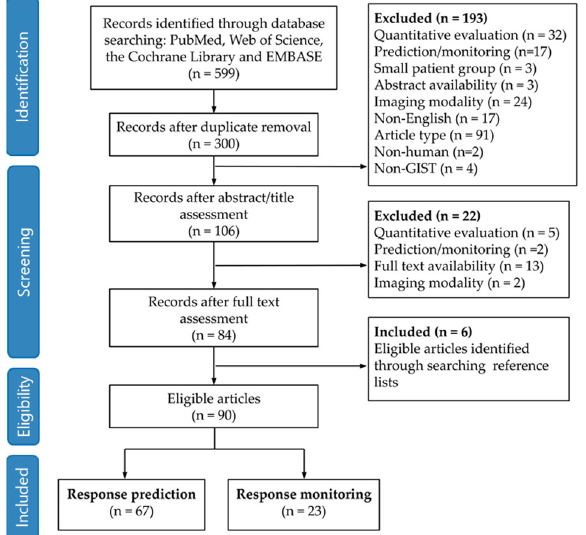
Figure 1. Preferred Reporting Items for Systematic Reviews and Meta-analysis (PRISMA) flowchart showing all the exclusion criteria. A total of 90 articles were included for this systematic review. Sixty-seven articles covered the topic of response prediction, and 23 articles covered the topic of response